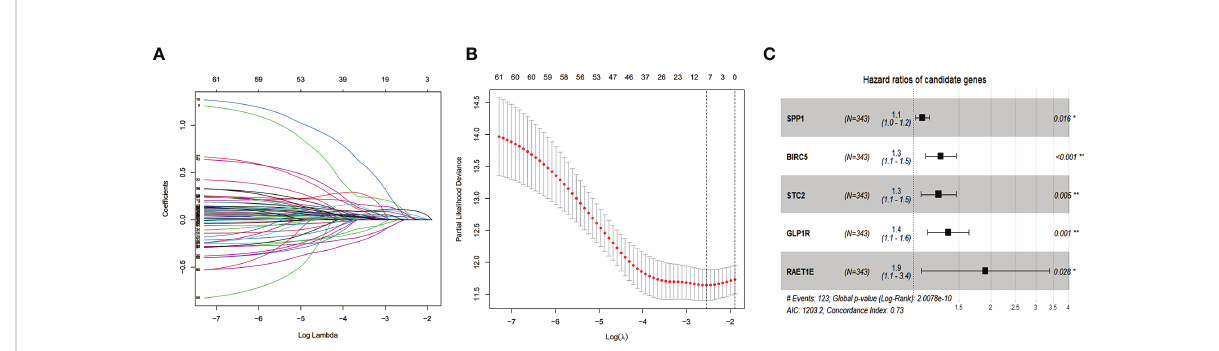
FIGURE 3 Establishment of Immune-related prognostic signature. (A) Screening of optimal parameter (lambda) at which the vertical lines were drawn. (B) Lasso coef fi cient pro fi les of the seventeen IRGs with non-zero coef fi cients determined by the optimal lambda. (C) The forest plot of multivariate cox analysis to develop a prognostic index based on 5 IRGs.